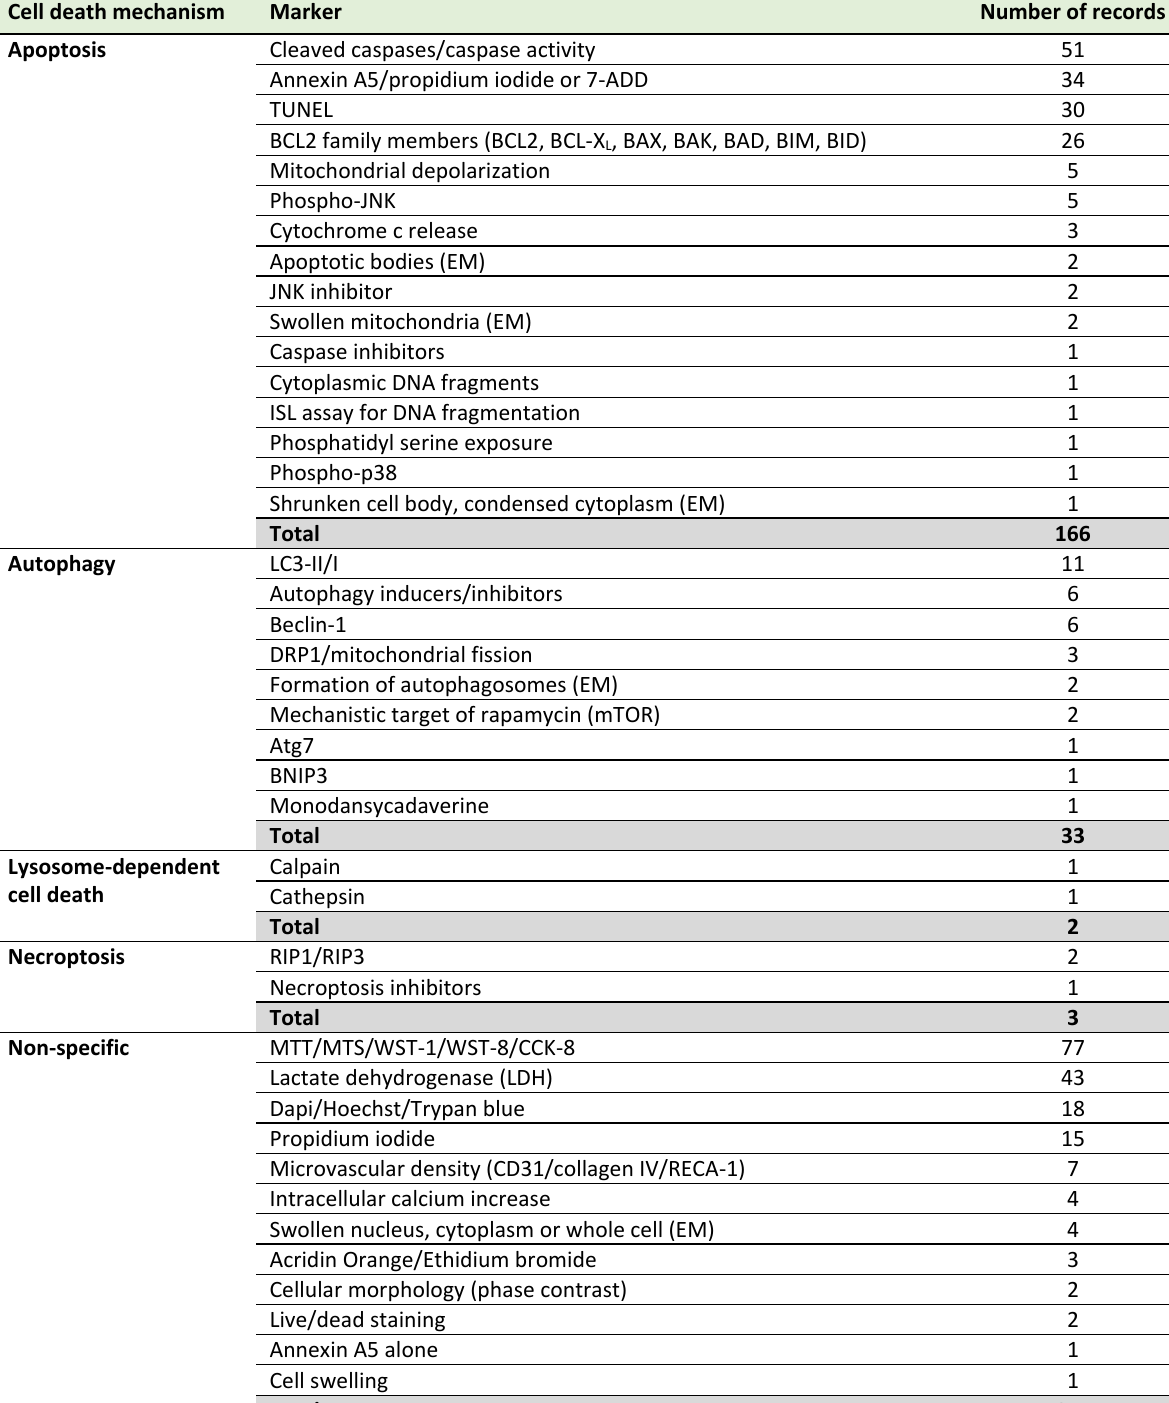
TABLE 2. Distribution of records according to cell death mechanisms and markers. Cell death